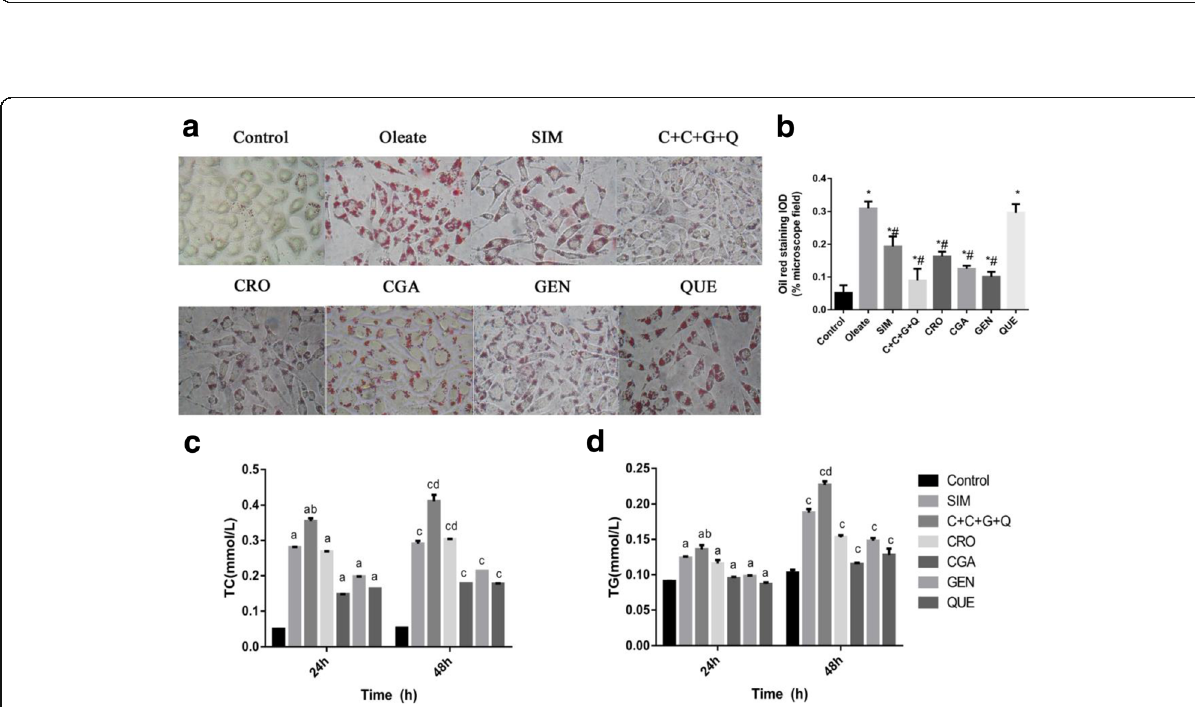
Fig. 2 The effects of different concentrations of CRO, CGA, GEN and QUE on the viability of HepG2 cells for 24 h or 48 h. Data are expressed as mean ± SEM from at least five independent experiments